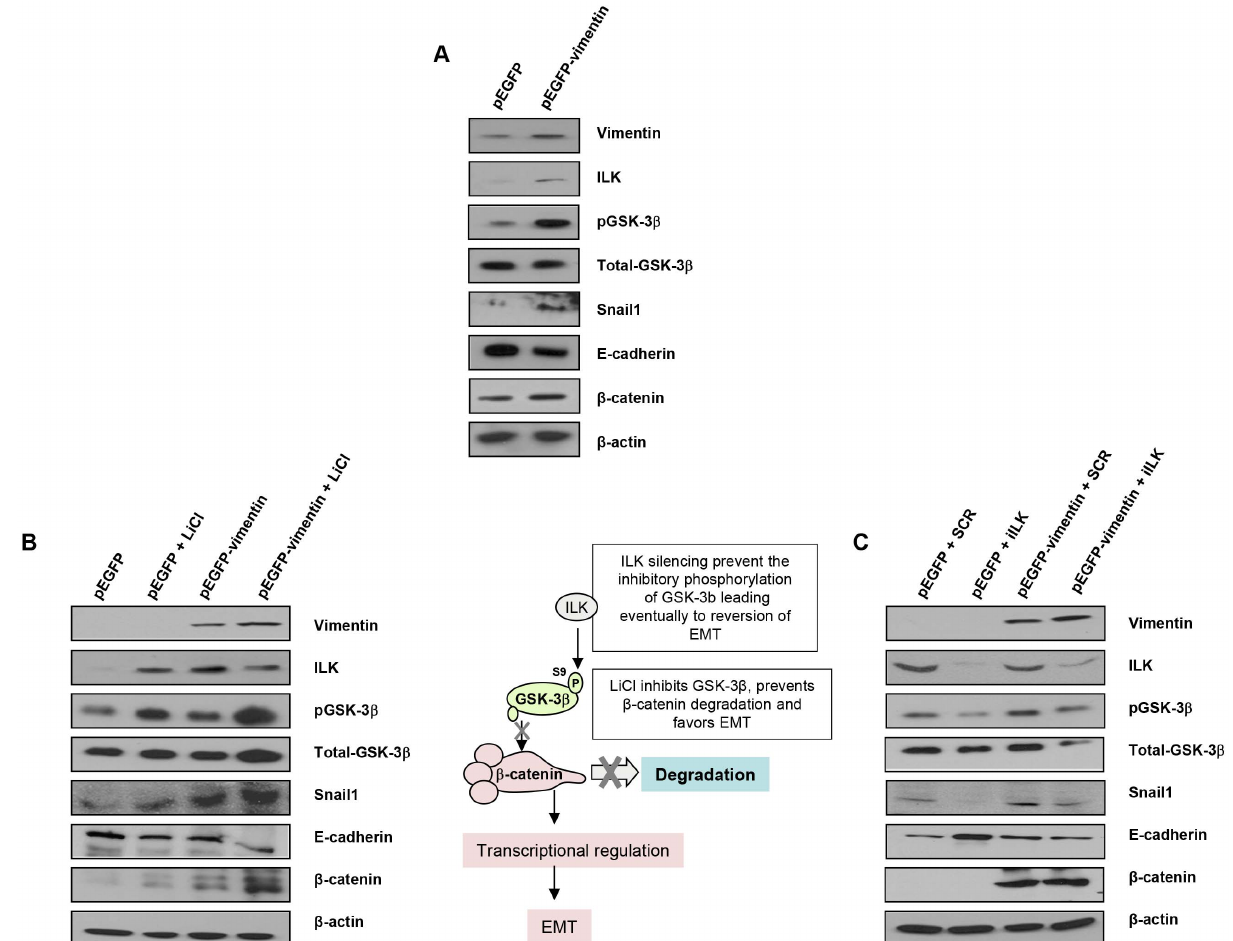
Figure 5. Interaction between vimentin over-expression and the activation of EMT signaling pathway. ( A ) Over-expression of vimentin in G361 cells. ( B ) Forced expression of vimentin drives human breast tumor epithelial cells (MCF7) to a mesenchymal phenotype through the integrin- linked-kinase/GSK-3 b axis. 5 mM LiCl was used to inhibit GSK-3 b , as detected by the accumulation of beta-catenin. ( C ) ILK was knocked down to analyze the significance of the interaction between vimentin and ILK in promoting the transition to a mesenchymal phenotype.